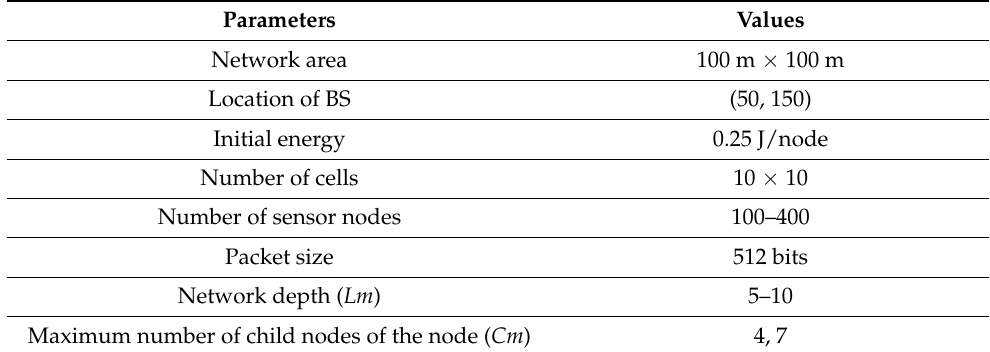
Table 1. Simulation parameters.